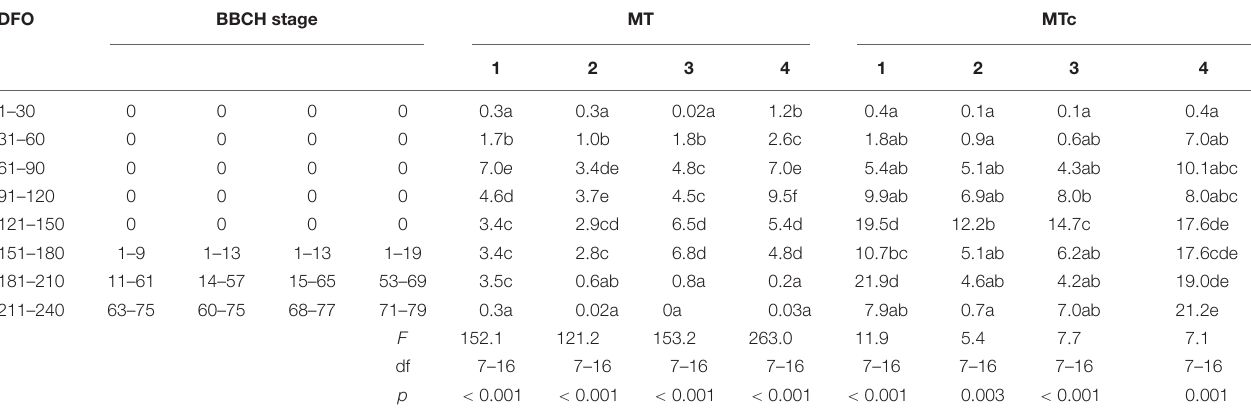
TABLE 1 | Phenological stage of grapevine (BBCH scale a ) and average germination percentages of P. viticola oospores, which had been stored under field (MT) or controlled (MTc) conditions for 0–240 days (DFO = Days from Overwintering) and incubated at 20 ◦ C for 14 days and results of statistical analysis (ANOVA and multiple comparison of mean values b ) between years 1 and 4 and indication of the phenological stages of grapevine a .